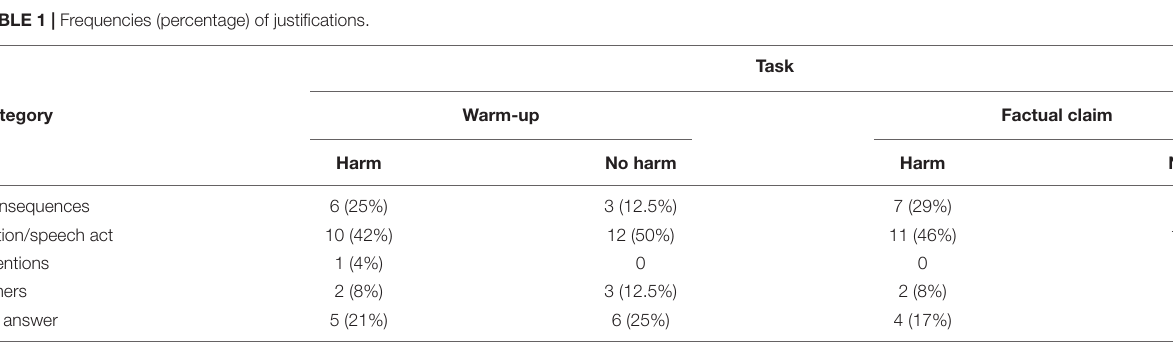
TABLE 2 | Association between evaluation and